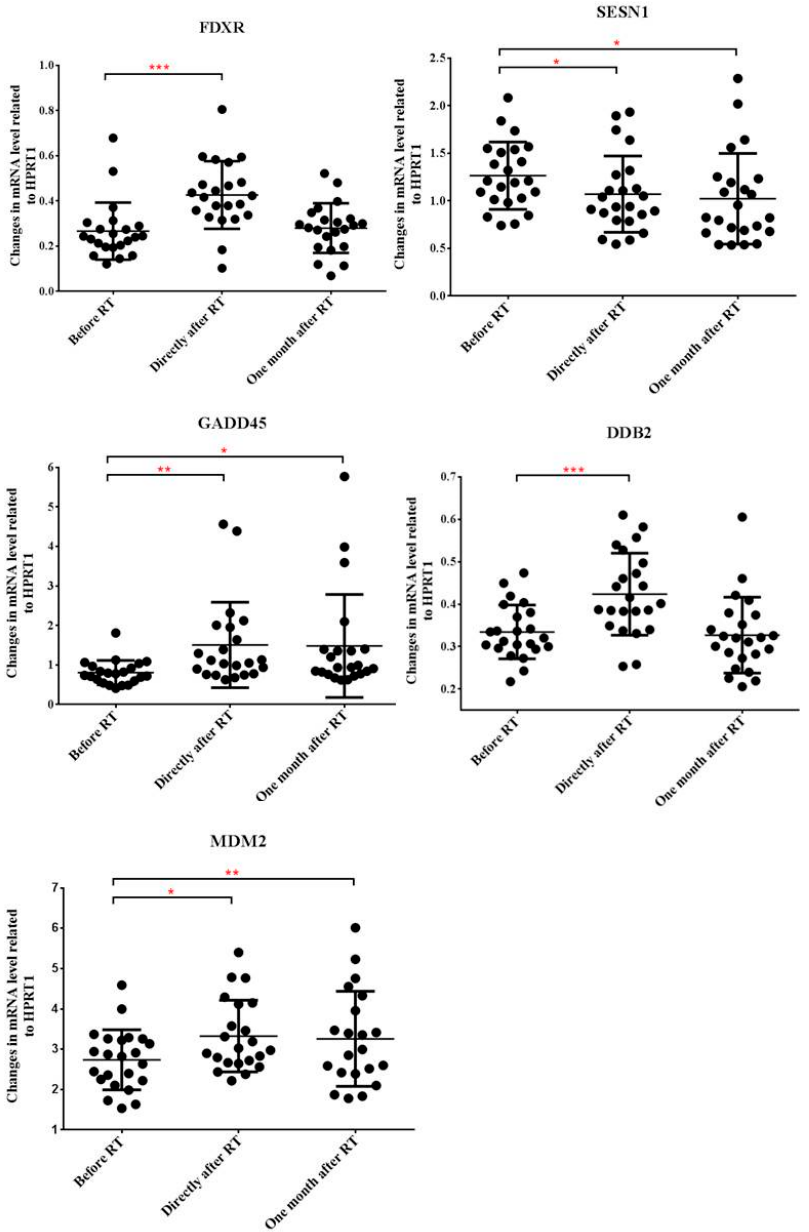
Figure 1. Expression of FXDR, SESN1, GADD45, DDB2 and MDM2 genes in the peripheral blood cells of head and neck squamous cell carcinoma (HNSCC) patients treated with RT. Blood samples were collected before the start of the treatment, directly after and one month after the last fraction of RT. RNA was isolated and qRT-PCR was performed as described in Materials and methods. Relative changes in the gene expression levels were compared between the three time points. Individual data points are shown together with the mean ± SD ( n = 23). Statistical analyses were performed in log transformed data. Significant differences (Paired-T-test, p ≤ 0.05) are indicated (* p < 0.05, ** p < 0.01, *** p < 0.001).